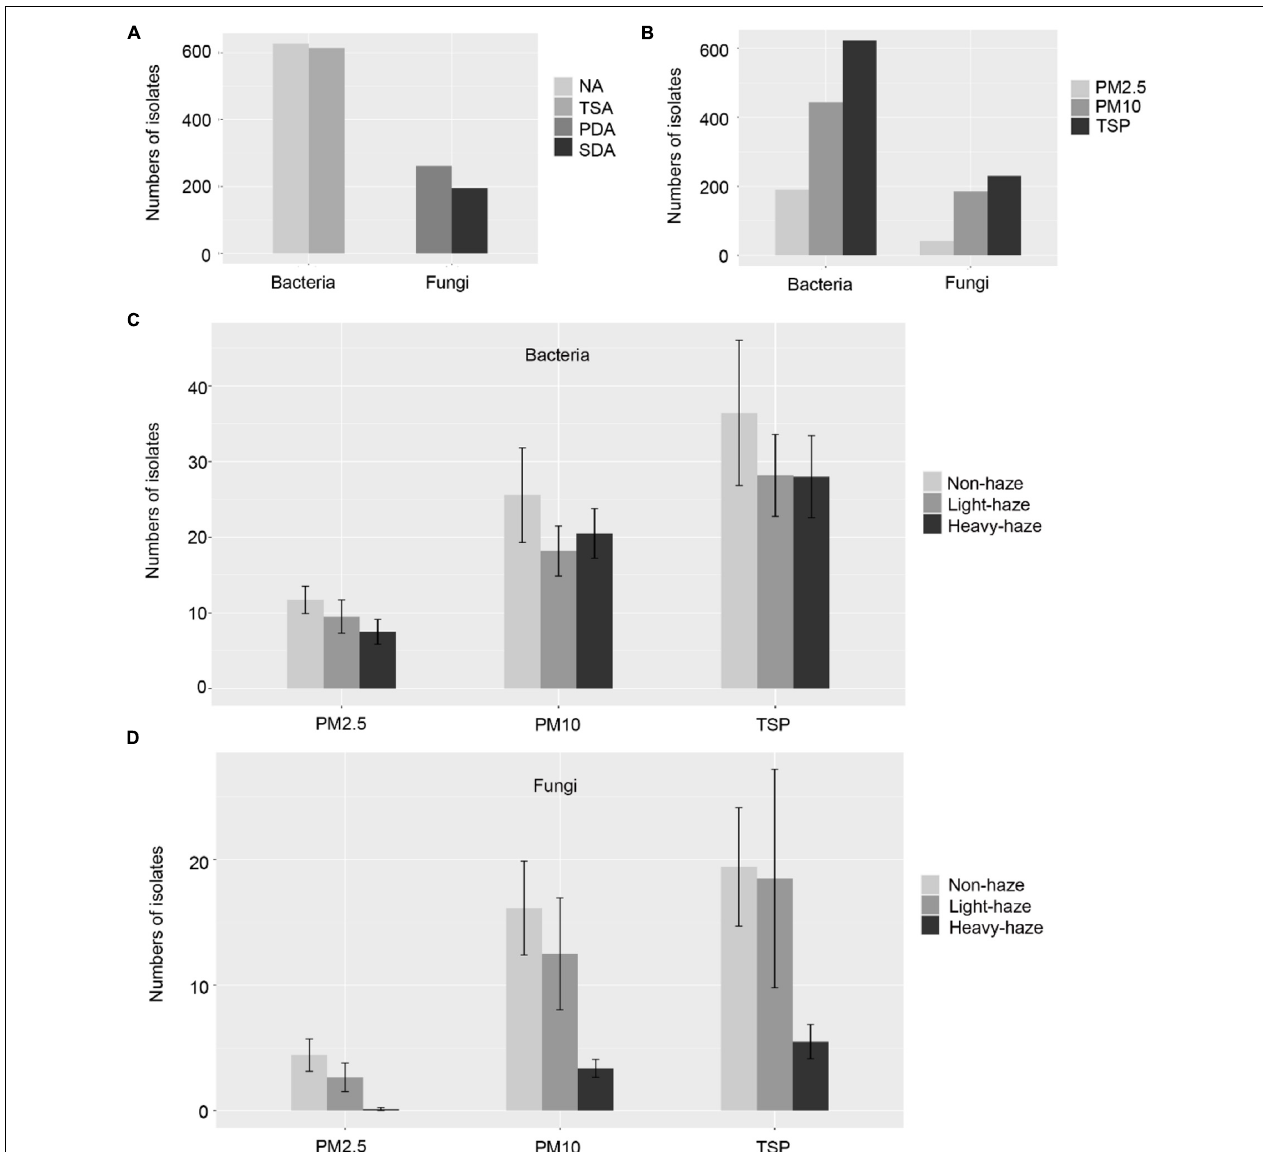
FIGURE 2 | Numbers of microbial isolates in various media (A) , PM samples (B) , and haze-level samples (C,D) . Values are shown as mean ± standard error (SEM) in panels (C,D) .